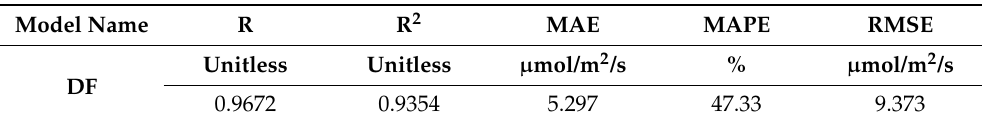
Figure 1. DF model’s predictions of C 3 S dissolution rate against experimental measurements of training and testing datasets. Coefficient of determination ( R 2 ) is shown in the legend, providing a measure of the prediction performance. The dashed line represents the ideal prediction. Table 3. R , R 2 , MAE , MAPE , and RMSE evaluating prediction accuracy of the DF model against the testing dataset.